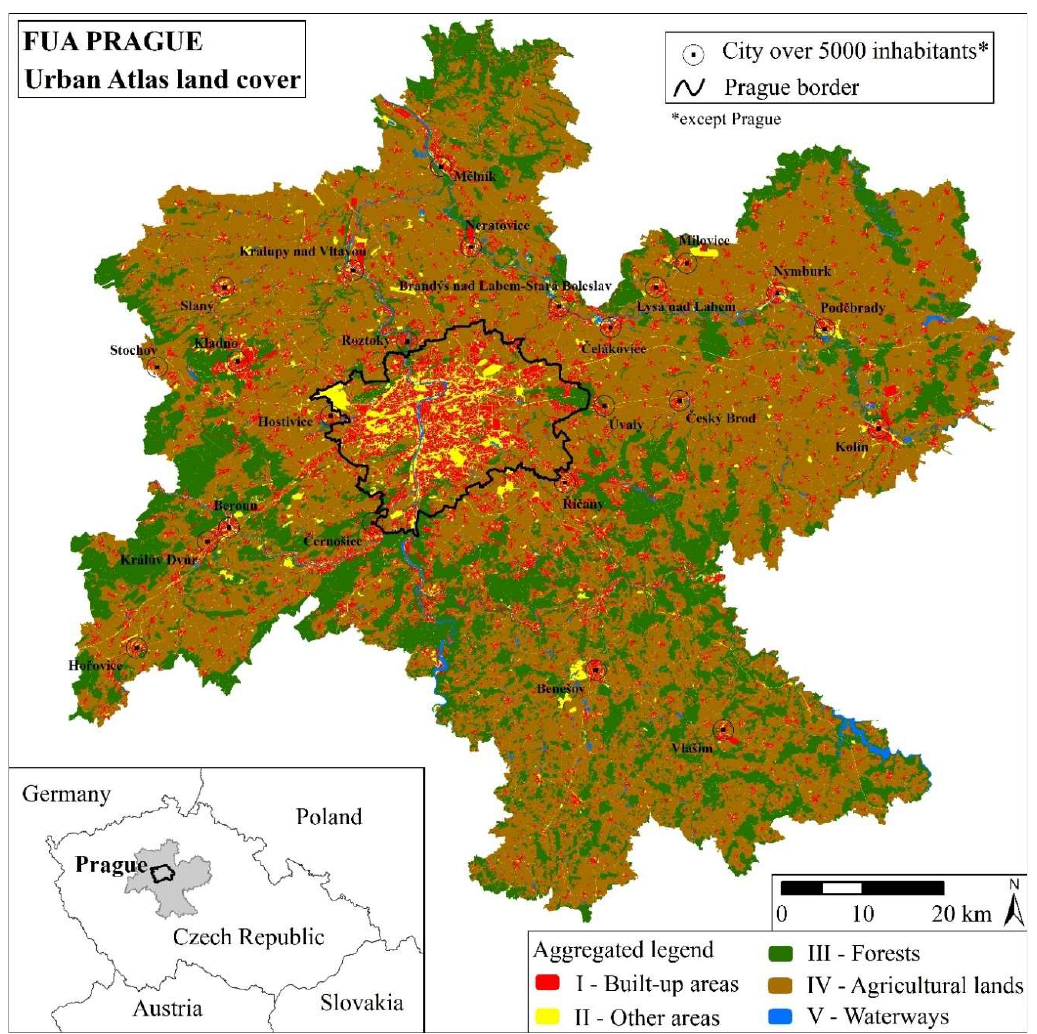
Figure 1. The study area. Source: [31–35].